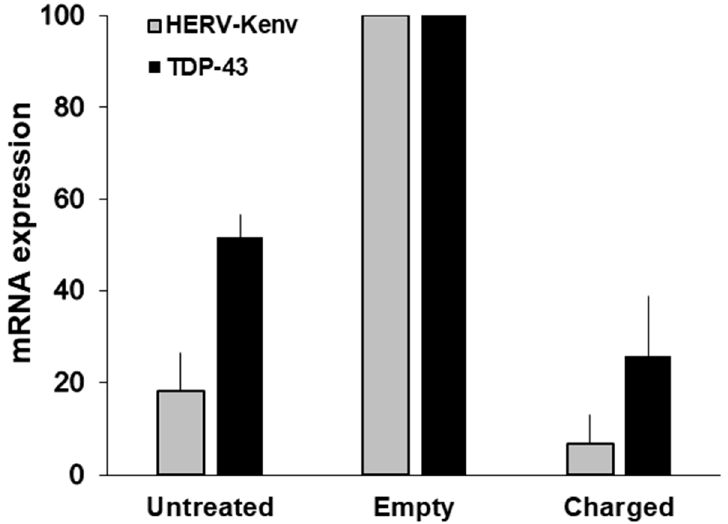
Figure 5. Levels of HERV-K env and TDP-43 mRNAs in LNCaP cells transfected either with the empty plasmid or with charged plasmid. The histograms represent the mean levels of HERV-K env and TDP-43 mRNAs, as detected by RT-qPCR, and are reported as percent of the value of mock-transfected cells in each experiment. Experimental conditions: Untreated cells, and cells either transfected with the empty plasmid, or with the plasmid charged with the Km3gRNA. For controls of specificity, methods and details, see [55].